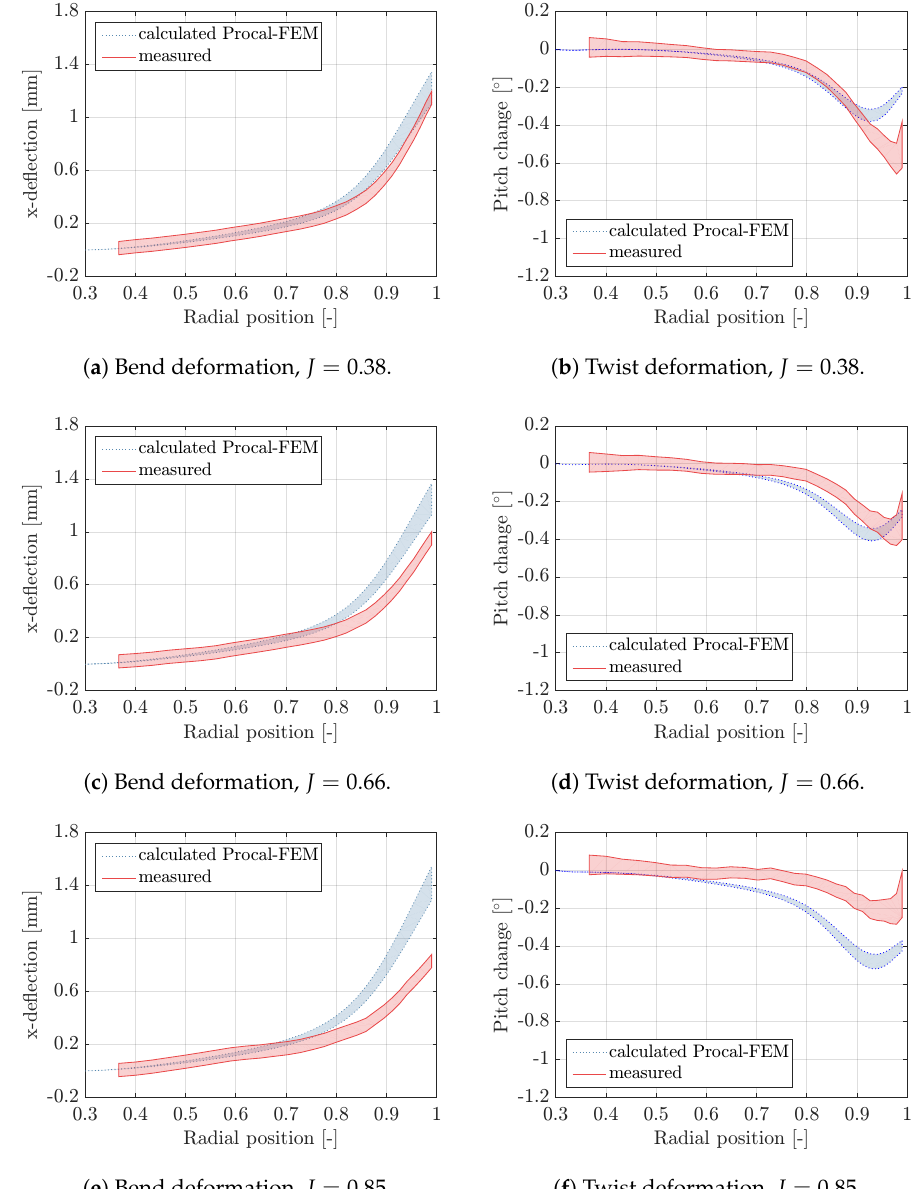
Figure 18. Uncertainty intervals for bend ( left ) and twist ( right ) deformations of mid-chord points of propeller 90 blade 2 against the radial position on the blade, for the measured and calculated